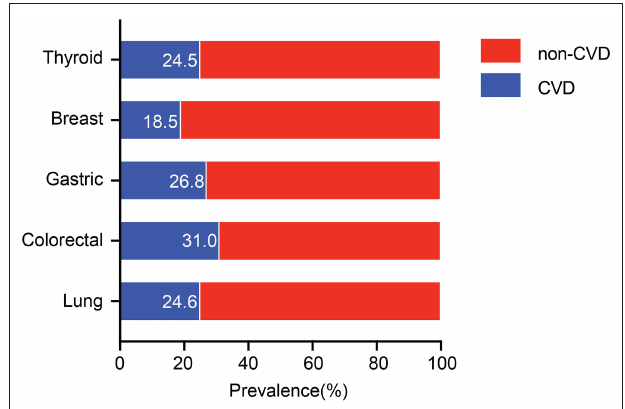
FIGURE 2 | Distribution of CVD among different cancers. CVD, cardiovascular disease.